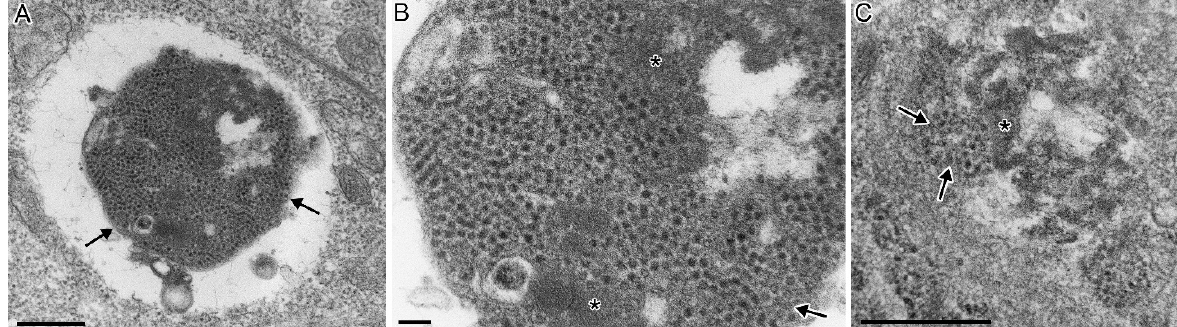
Figure 5. CHSE-214 cells infected with CTV-2. ( A ) dense accumulation of virions (arrows) surrounded by an electron lucent area within the host cell cytoplasm (bar = 500 nm). ( B ) Higher magnification from ( A ) showing viral capsids, empty capsids (arrow) and viral proteins (*) (bar = 100 nm). ( C ) Viral capsids directly within the cytoplasm (arrows) associated with viral proteins (*) (bar = 500 nm).